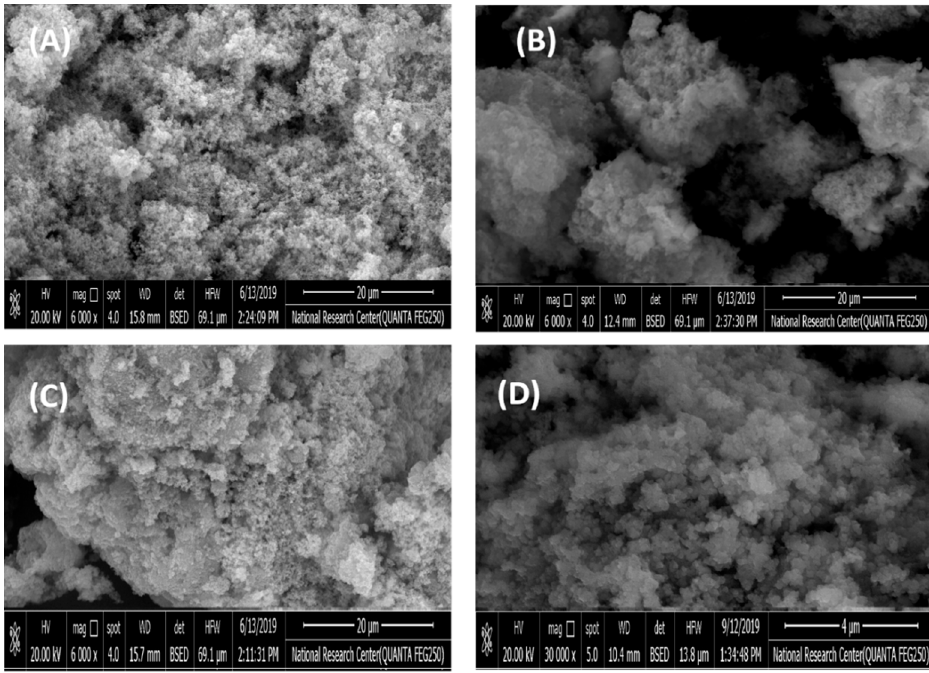
Figure 3. SEM of ( A ) SCB, ( B ) Ni-sorbed SCB, ( C ) SBDP, ( D ) Ni-sorbed SBDP nanocomposite. Molecules 2020 , 25 , x FOR PEER REVIEW